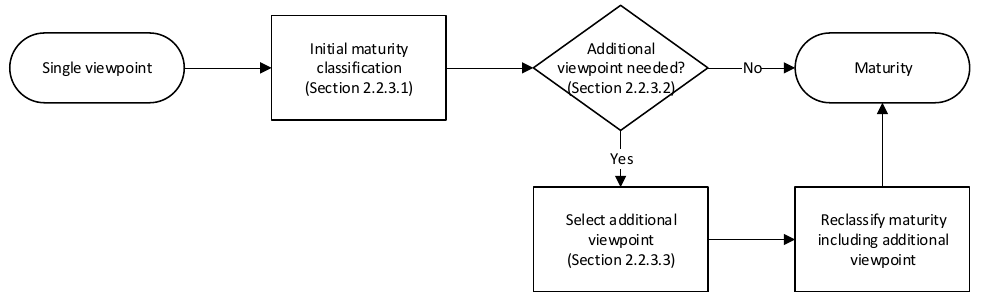
Figure 6. Dynamic viewpoint selection